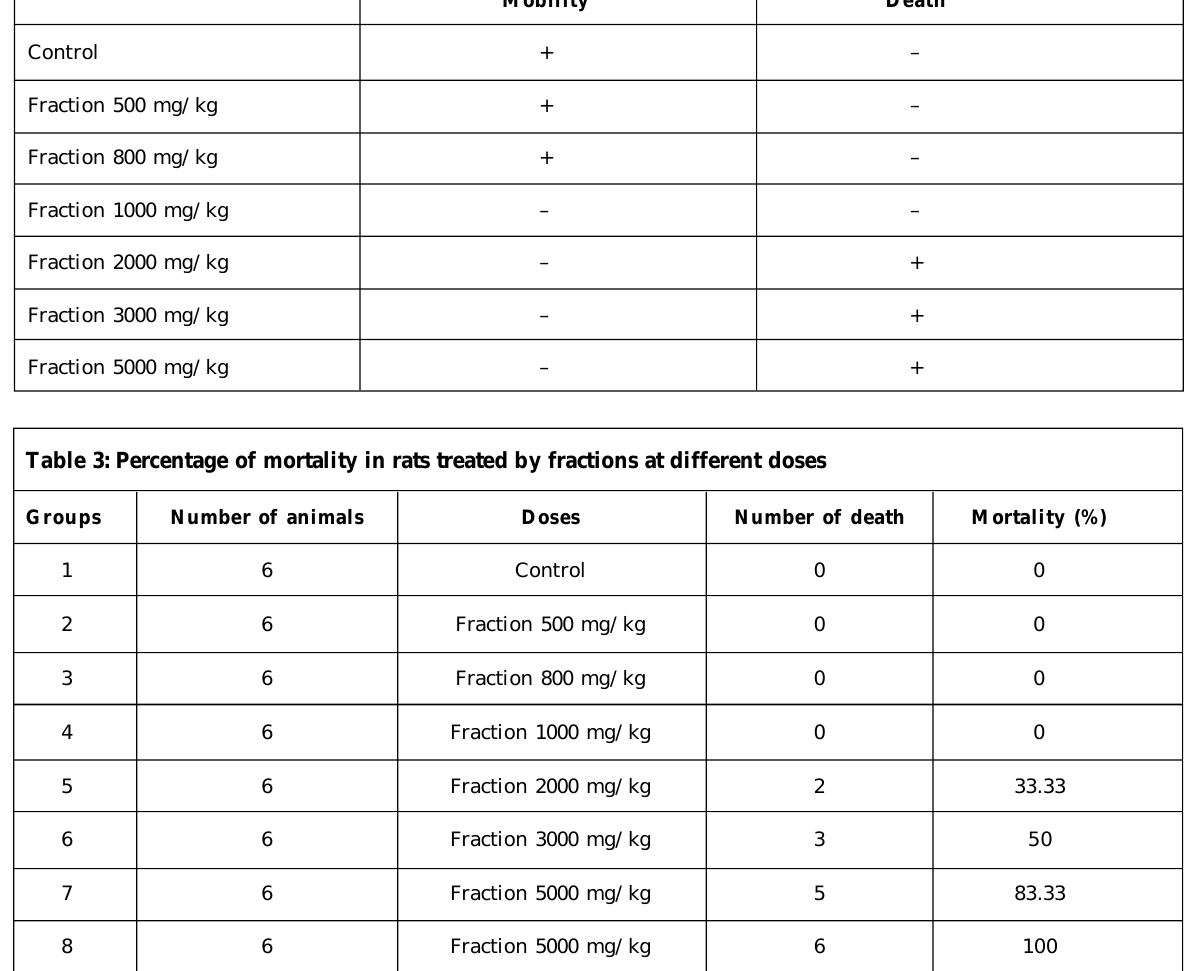
Table 2: Acute toxicity signs induced by fraction at different doses Groups Acute toxicity signs Mobility Death Control